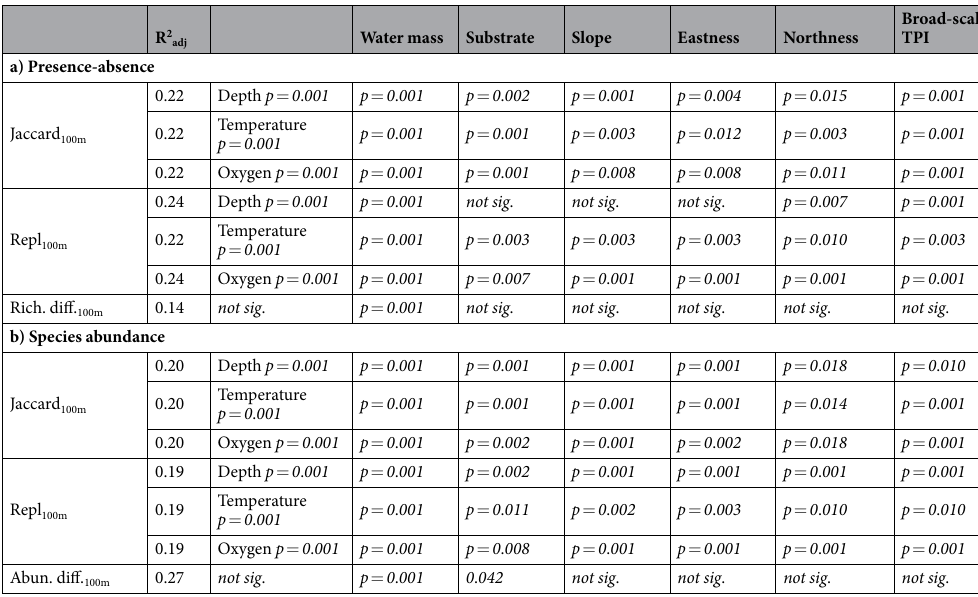
Table 1. Results from the Distance-based redundancy analysis (dbRDA) with a forward selection, showing the significant environmental variables (p < 0.05) affecting the Jaccard dissimilarity, species replacement,